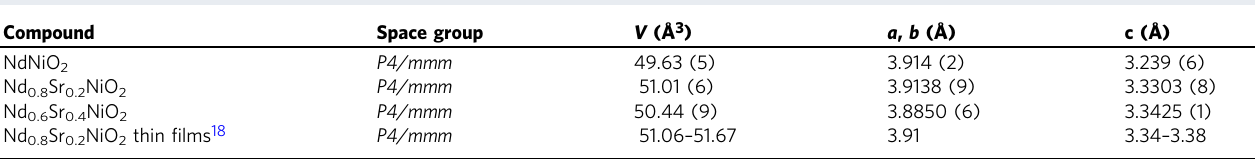
Table 1 Lattice parameters obtained from the Rietveld re fi nements. Compound